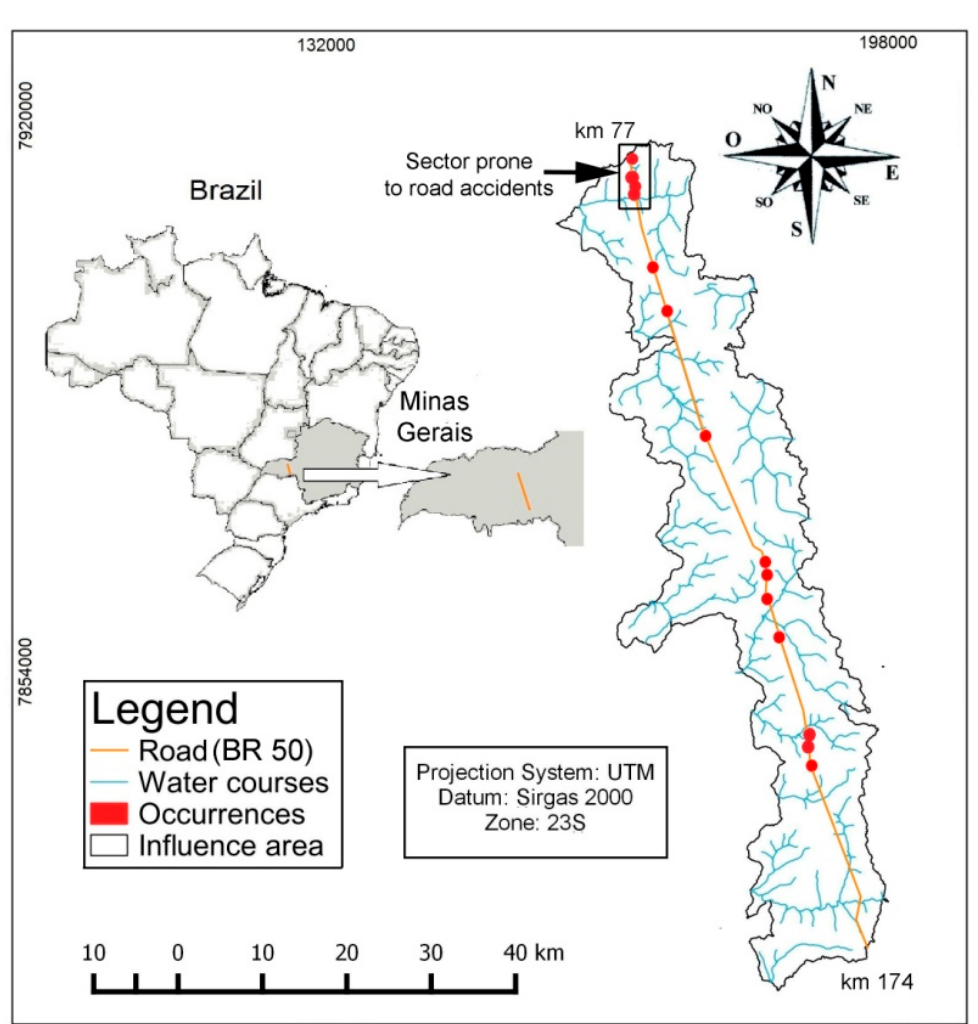
Figure 1. Geographic location of the studied BR 050 highway segment, in Brazil and Minas Gerais State, with representation of intercepted water courses and distribution of road accidents involving spills of hazardous substances. In the northern and central parts of this segment the road was built nearly along a water divide. In these sectors the water channels are likely to be equally vulnerable to contamination at both sides of the road, because the spill of a harmful substance will potentially leach in both directions. For similar reasons, in the southern part the water channels from the west side are potentially more vulnerable than the channels from the east side.